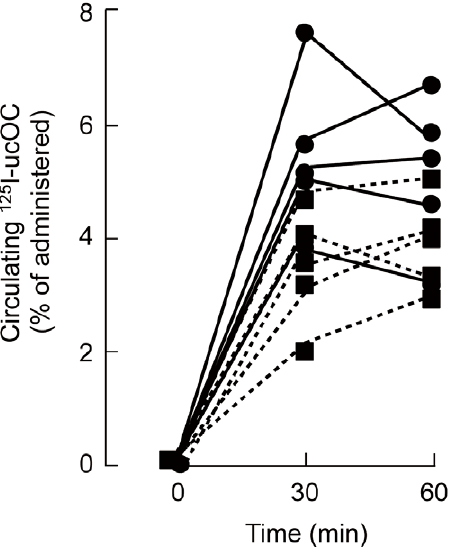
Figure 6. Absorption of 125 I-labeled ucOC into the systemic circulation. Mice were administered 125 I-labeled ucOC (5 m g/kg, 4,000 to 6,000 cpm) intraperitoneally (circles, n = 5) or orally (squares, n = 5), and blood was collected into tubes containing 5 mM EDTA (to prevent coagulation) at 30 and 60 min thereafter for measurement of radioactivity. The percentage of the administered radioactivity present in the circulation was calculated assuming a total blood volume of 2 ml. The amount of radioactivity per wet tissue weight for the thymus of the treated mice was found to be similar to that for other organs such as the liver, whereas the thymus of mice administered Na 125 I instead of 125 I-ucOC preferentially accumulated radioactivity. These findings indicate that the radioactivity in the ucOC preparation was present mostly in the form of the labeled peptide rather than as free Na 125 I.